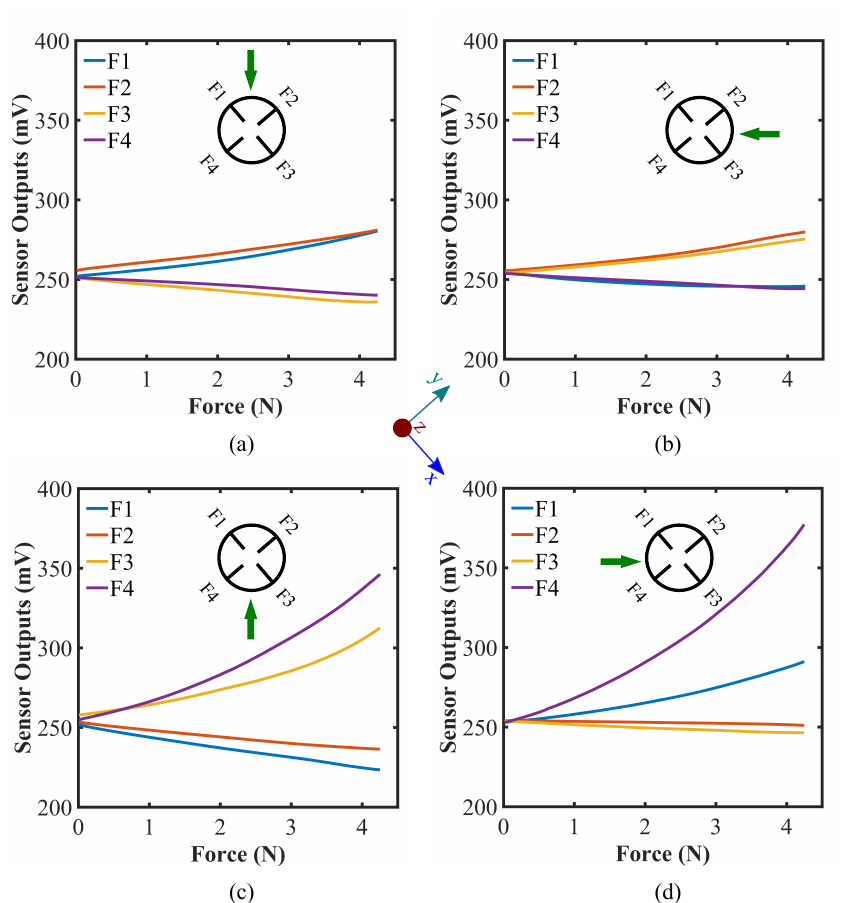
Figure 6. Force calibration against forces on the sides of the hemispherical sensor (at 30 ◦ latitude), (in-between the inserted flex sensors) with 45 ◦ along ( a ) -y-axis, ( b ) -x-axis, ( c ) y-axis, and ( d ) x-axis (measuring angle clockwise); top view of the sensor system is shown and the green arrow indicates the exerted force